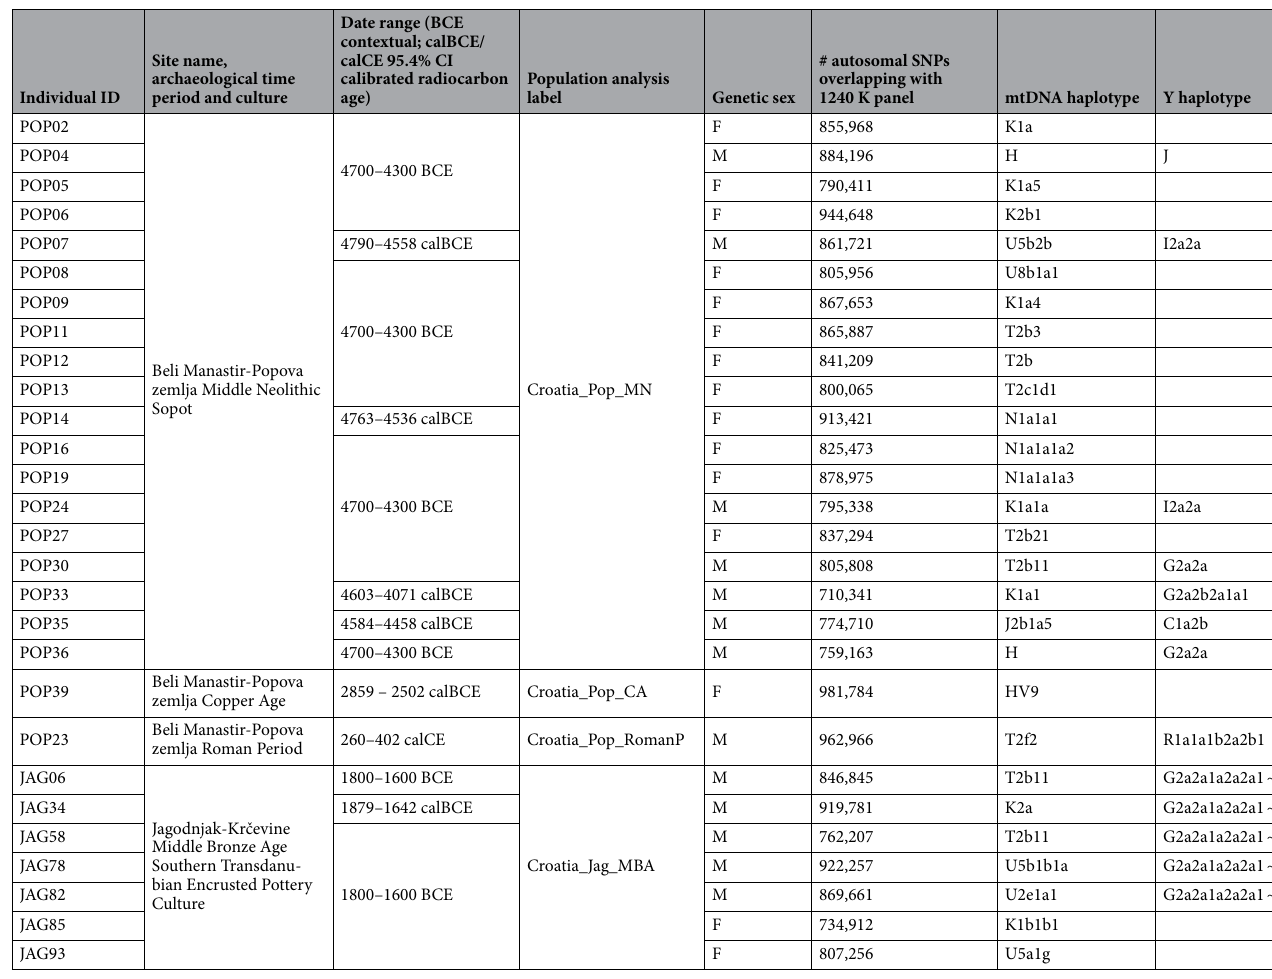
Table 1. Summary information for ancient samples first reported in this paper. Capture data and calibrated radiocarbon dates for POP07 and POP14 were previously reported in 2 . See Methods and Supplementary Table S1 for further information about data provided in the